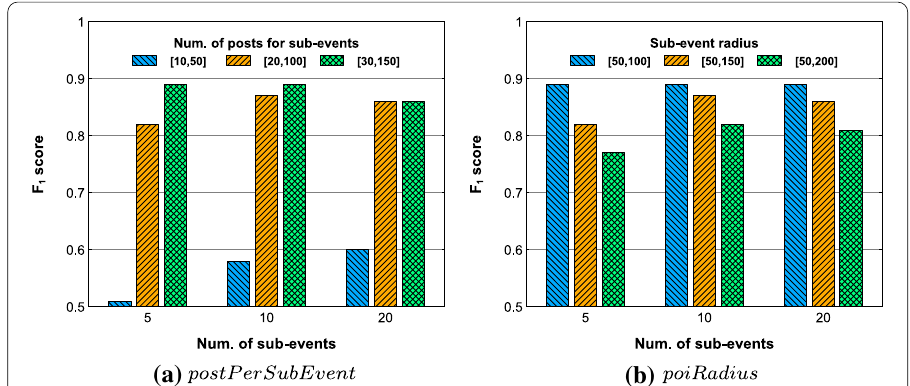
Fig. 5 F1-score for different values of the number of posts per sub-event ( postPerSubEvent ) and radius in meters ( poiRadius ) of a sub-event